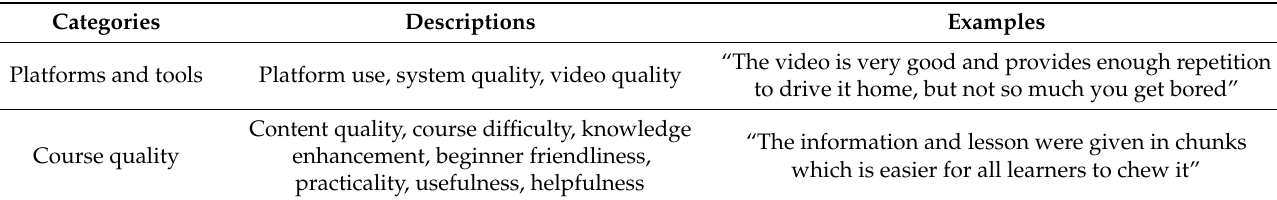
Table 1. Coding scheme for course review